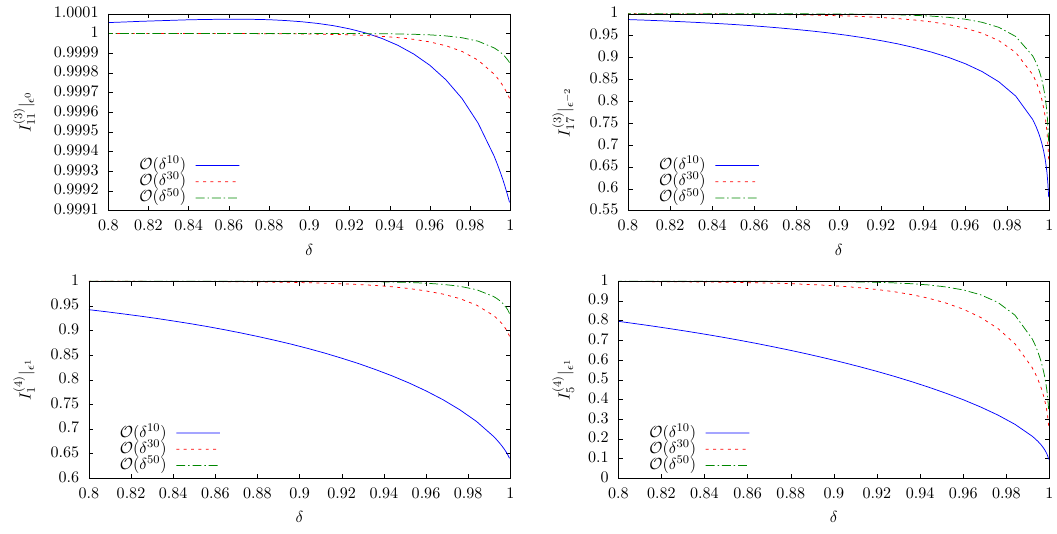
Figure 12 . Comparison of exact and expanded phase-space master integrals for four typical examples, where the results are normalized to the exact expressions. The panel in the top row correspond to three-particle cut master integrals and the corresponding pictures can be found in figure 8. The pictures for the four-particle cut master integrals in the bottom row can found in figure 9. The considered (cid:15) order is indicated on the y -axis